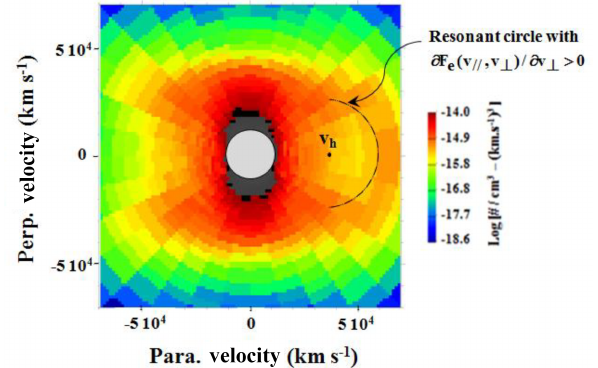
Figure 4. Enlargement of Fig. 3b illustrating the integration surface in the EH stationary frame. The centre of the resonant circle (dashed line) is at parallel velocity V h , equal to half the beam velocity. Only the part of this circle which passes the positive perpendicular ve- locity space gradient contributes to a positive growth rate for the cyclotron maser instability; it is limited to − 45 ◦ <θ < 45 ◦ .